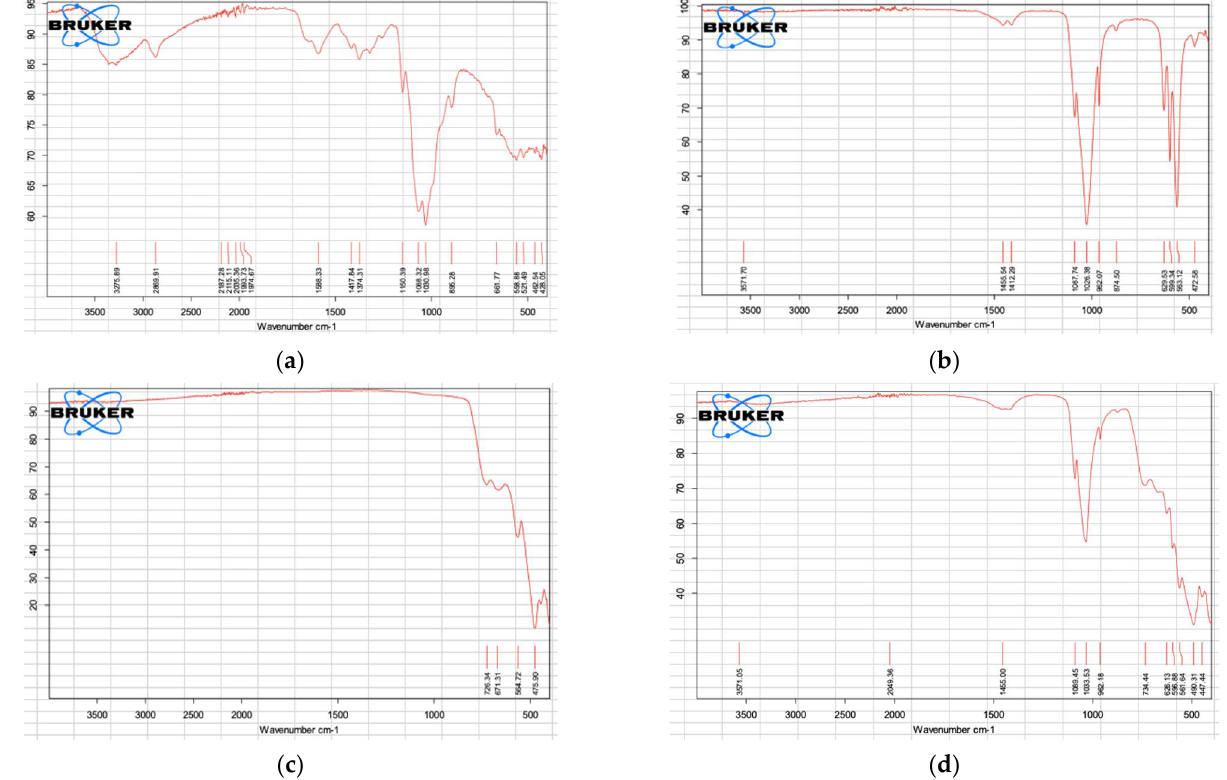
Figure 1. FTIR spectra. ( a ) COS. ( b ) BHA. ( c ) ZrO 2 . ( d ) Experimental pulp-capping agent COS-BHA.